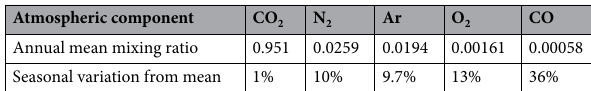
Table 1. Annual mean volume mixing ratios for the Martian atmosphere 26 .